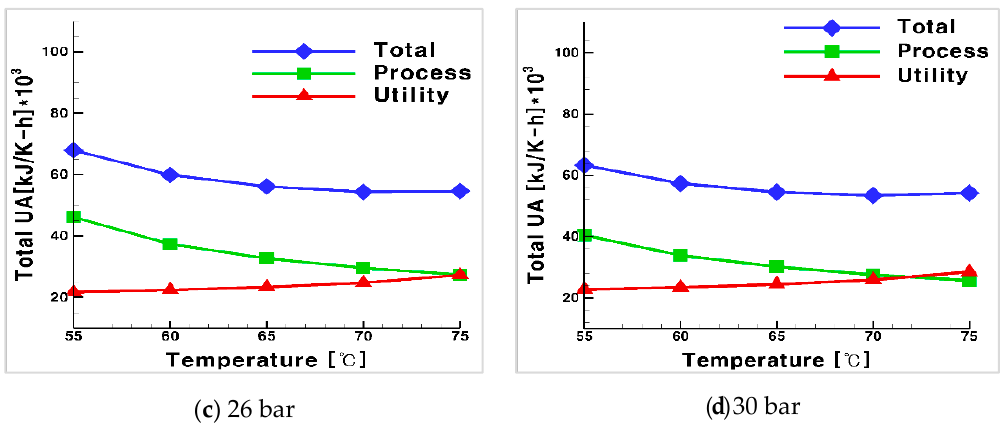
Figure 7. Changes in the total UA based on the pressure in each group when using CO 2 ( a ) 18 bar; ( b ) 22 bar; ( c ) 26 bar; ( d ) 30 bar.